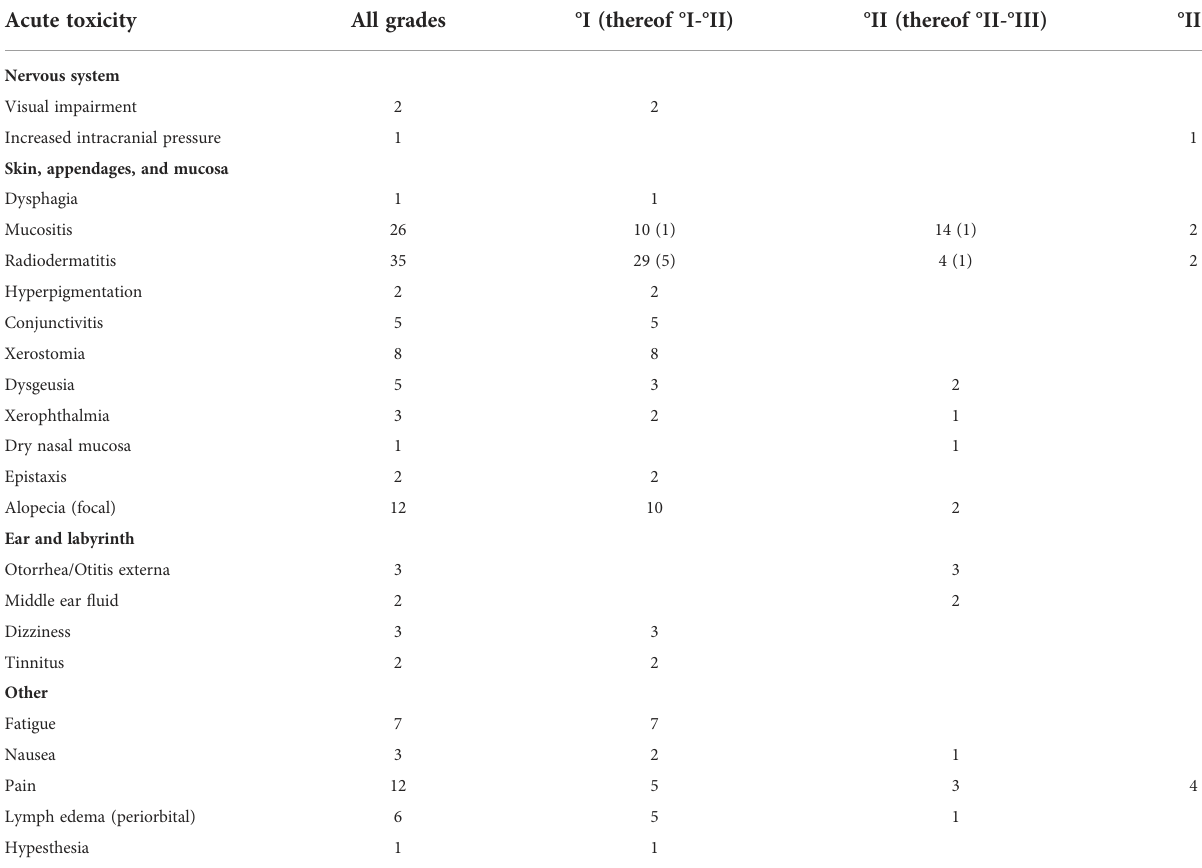
TABLE 3 Acute toxicity of patients with craniofacial osteosarcoma